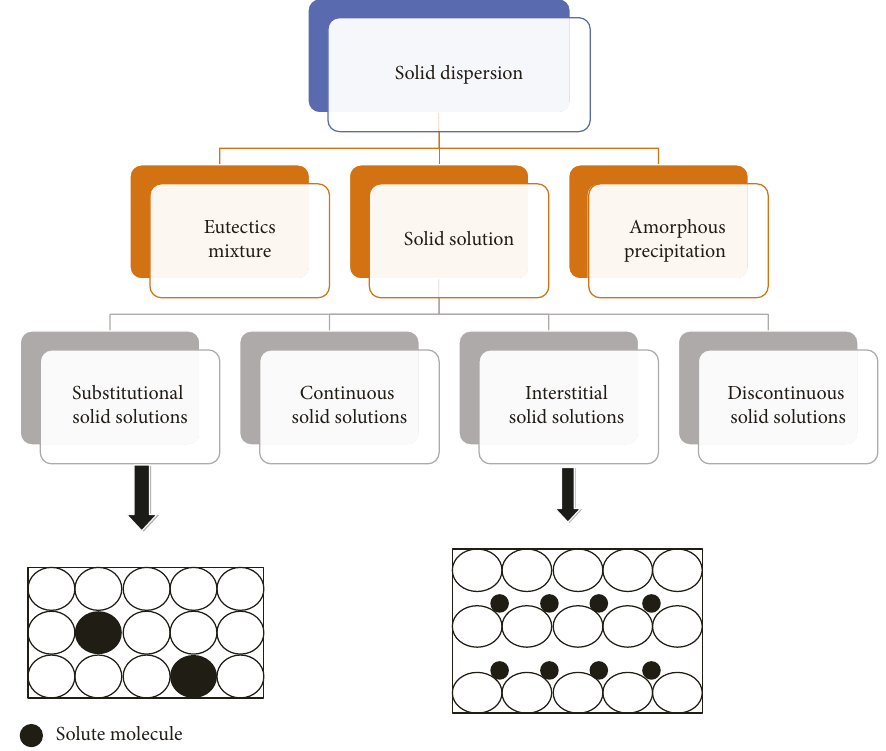
Figure 2: Classifications of solid dispersion